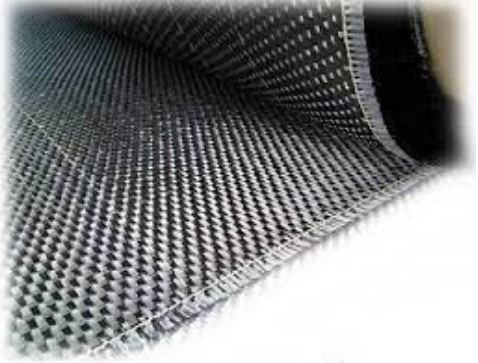
Figure 1. Carbon fiber mesh.